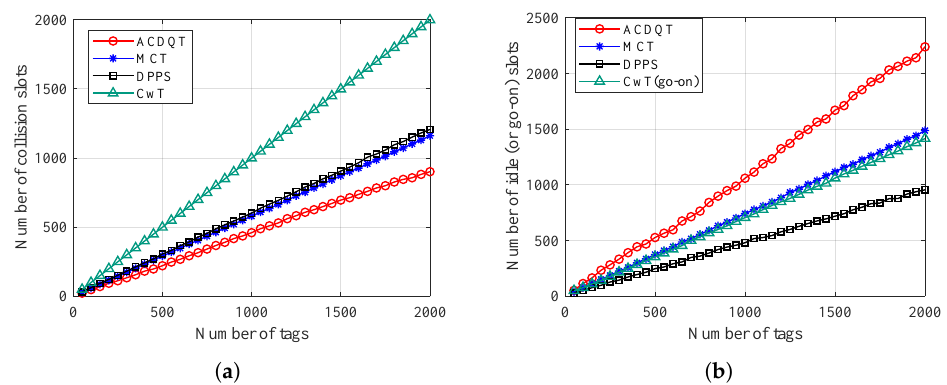
Figure 8. Number of slots needed to identify tags: ( a ) collision slots; ( b ) idle (or go-on)